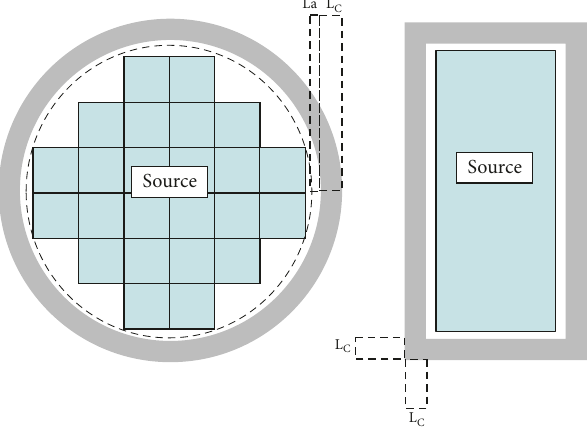
Figure 5: Model for the thickness of the materials used for the shielding of radiation.